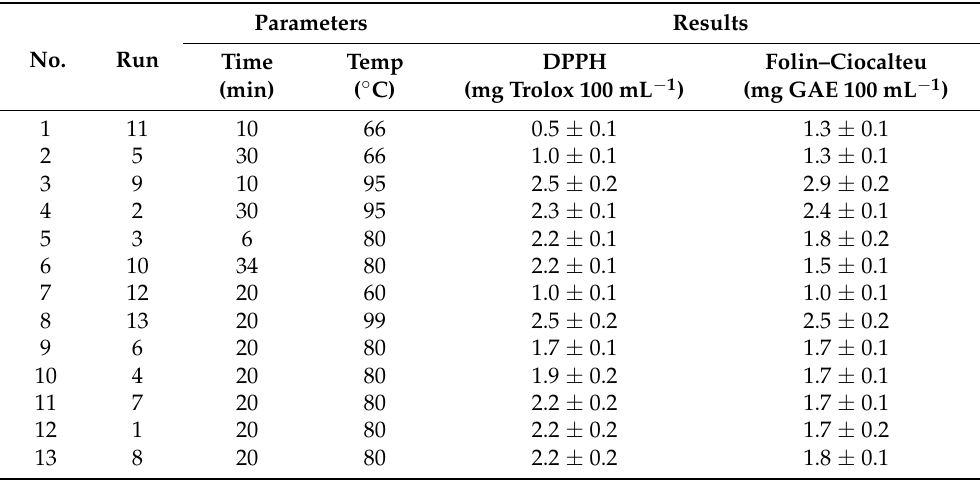
Table 2. The optimization parameters and